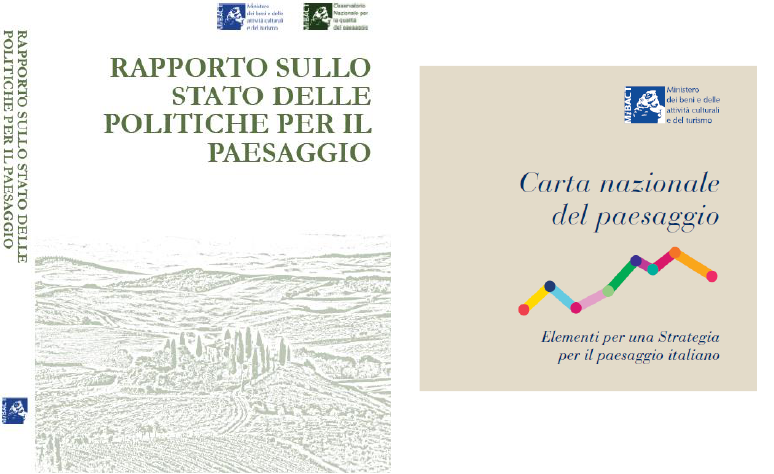
Figure 4. The first (and currently last) National Report on the State of Landscape Policies in Italy (2017) and the National Landscape Charter (2018).